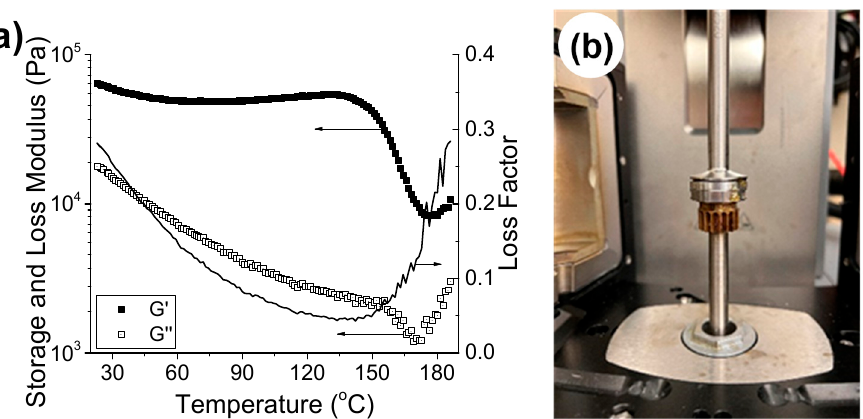
Figure 3. ( a ) Temperature sweep of the PBA elastomer from a temperature of 25 to 190 °C. The loss factor is the tan δ = G”/G’. The sweep was conducted at a frequency of 10 rad/s and a constant applied shear strain of 0.1%. The applied normal force was 1 N. ( b ) Picture of the DMA set-up after network degradation during the temperature sweep experiment. The degraded network became a liquid which flowed over the side of the sample plate.